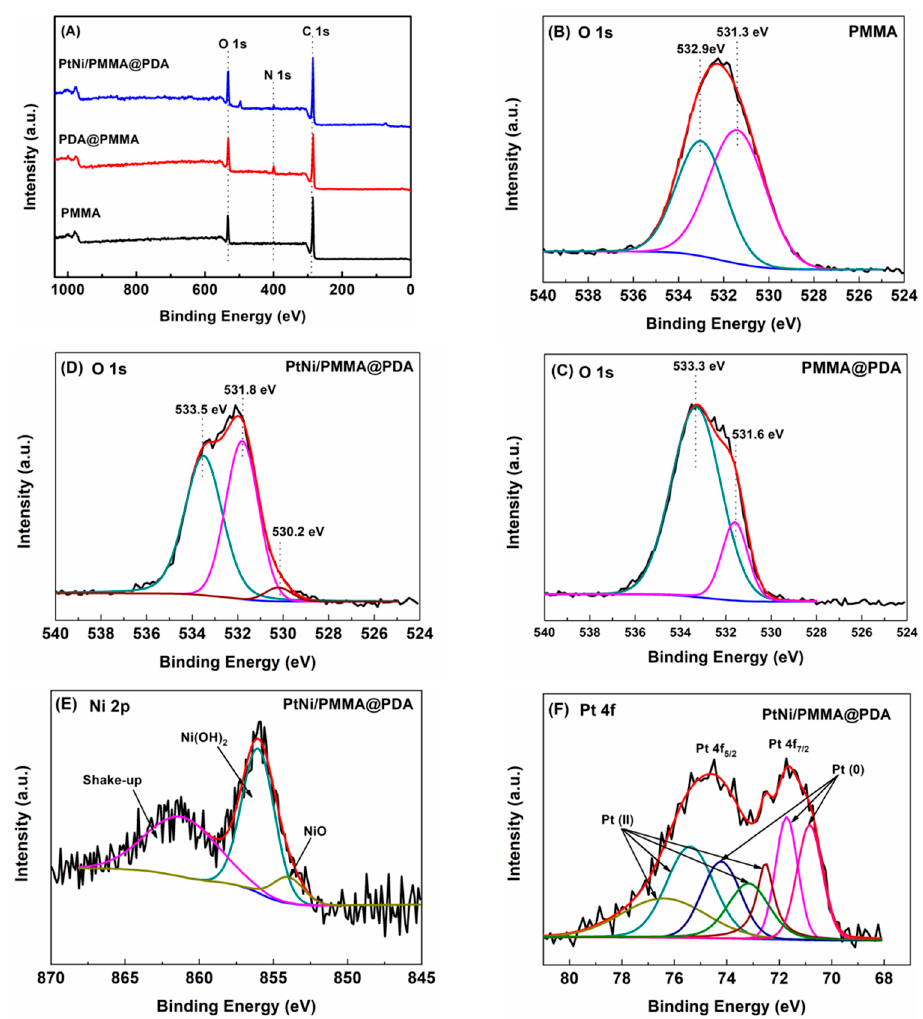
Figure 4. XPS spectrum: Wide survey spectra of the fibrous membranes from each process ( A ); O 1s of PMMA ( B ); PMMA@PDA fiber ( C ) and PtNi/PMMA@PDA ( D ); Ni 2p ( E ) and Pt 4f ( F )